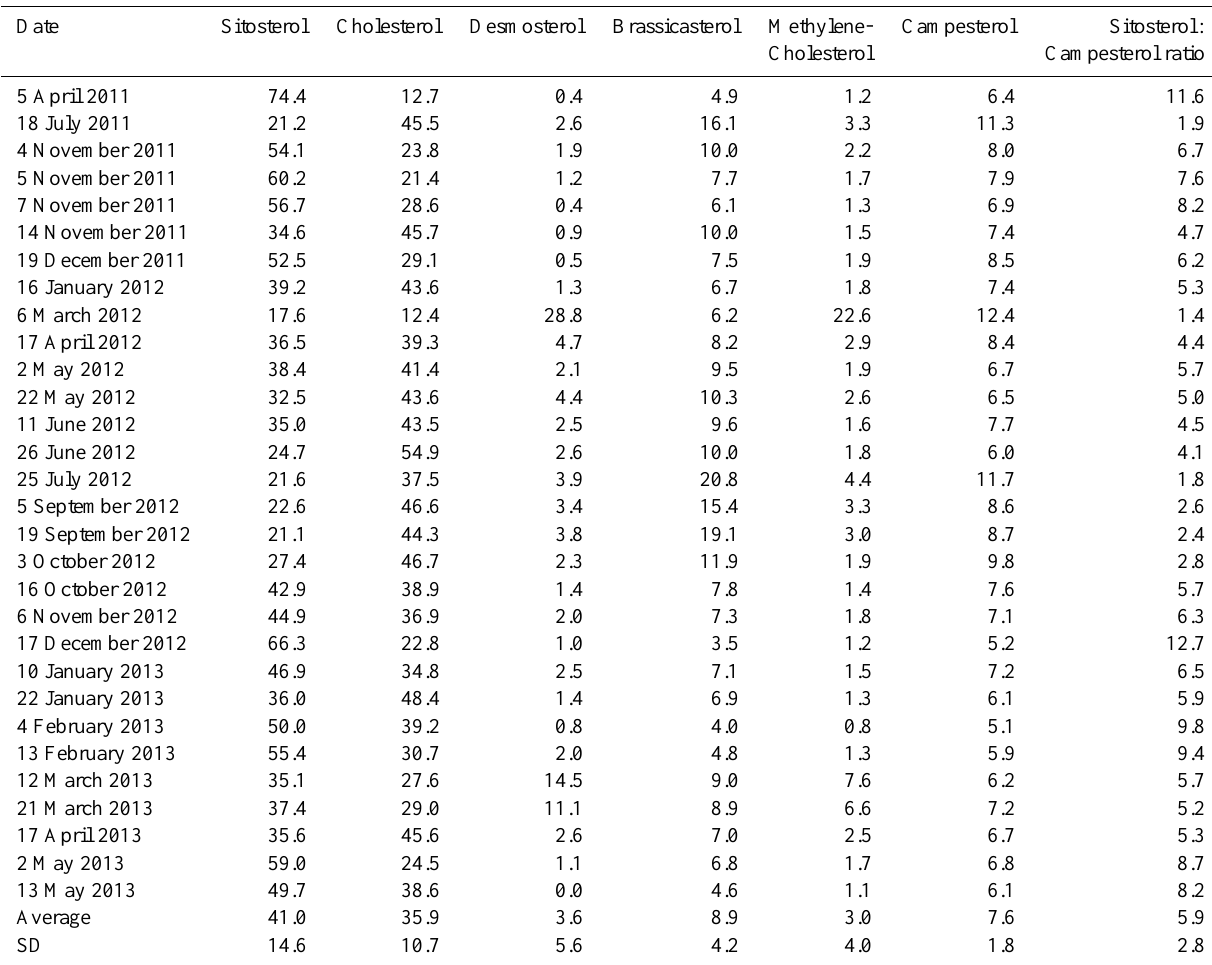
Table 1. Percentages of sterols (relative to the sum of sterols quantified), and sitosterol : campesterol ratio in the samples investigated. Date